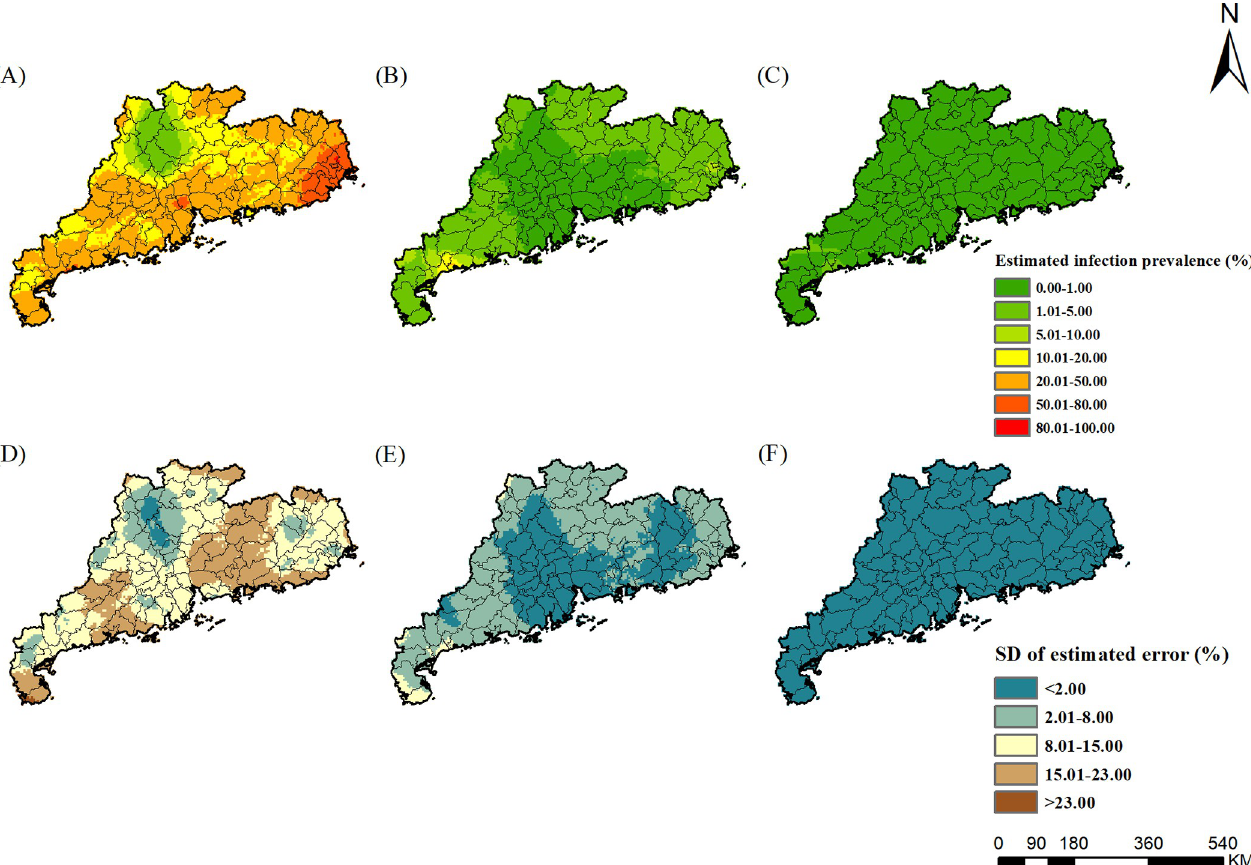
Fig 3. The geographical distribution of T . trichiura infection risk in Guangdong. (A)-(C) present T . trichiura infection during the periods of 1988–1992, 2002–2003, and 2015–2016, respectively. (D)-(F) present the corresponding standard deviation of the estimated uncertainty. The base layer derived from https://www.webmap.cn/mapDataAction.do?method=forw&keysearch=indexSearch with credit to National Catalogue Service For Geographic